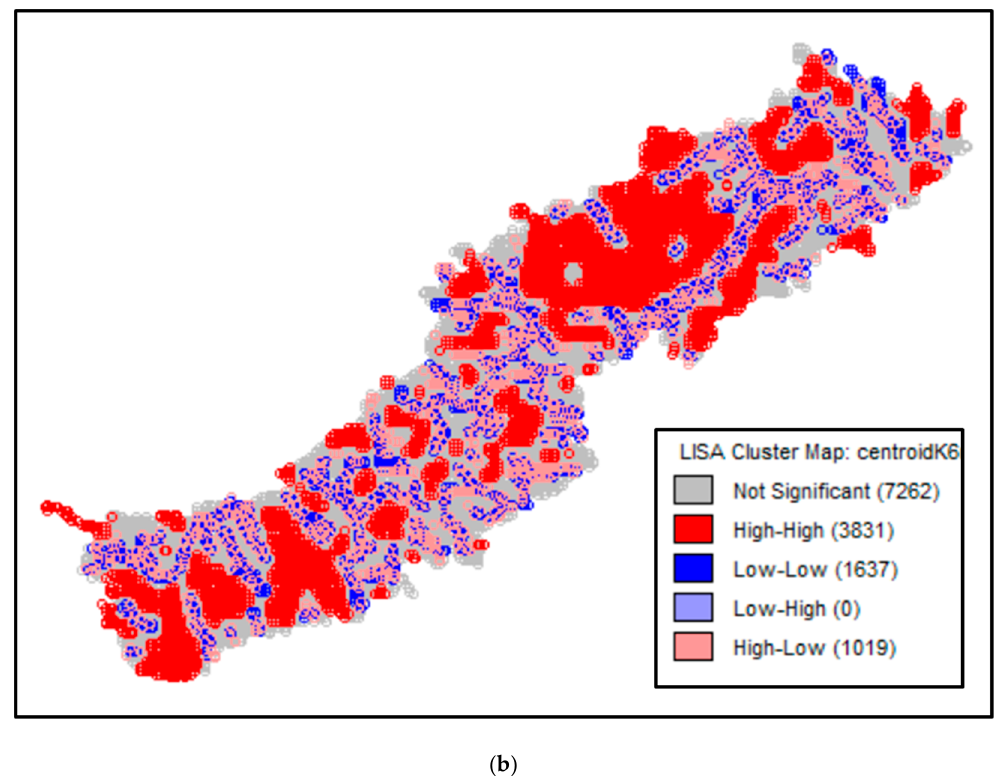
Figure 9. Autocorrelation map of the HDI (Hydro Distance Index)—( a ) scatter plot and ( b ) cluster map.